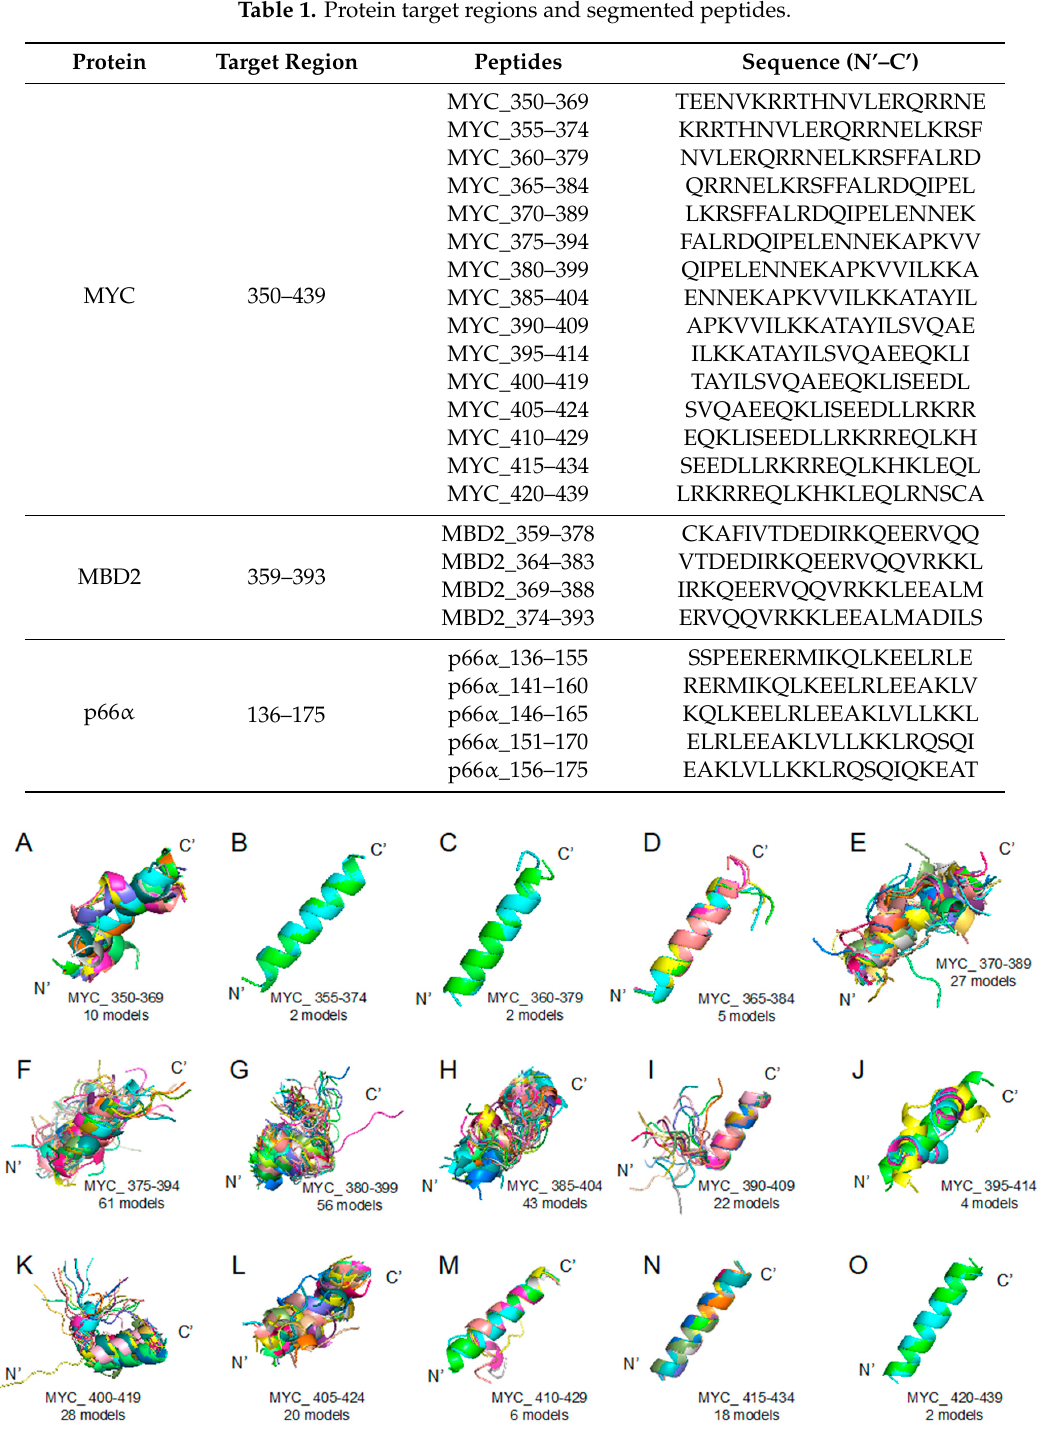
Figure 1. Myc proto-oncogene protein (MYC) 350–439 region segmented peptides: PEPFOLD ver 3.5 prediction result (see the Section 3. Materials and Methods) of peptide structures based on